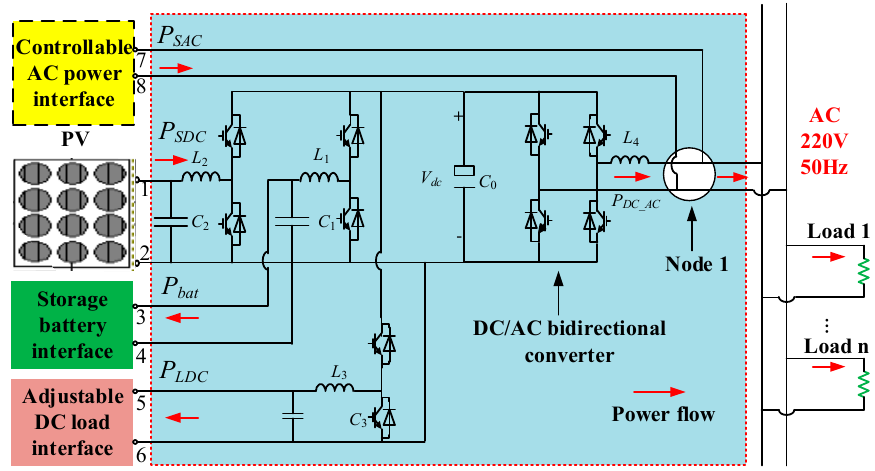
Figure 13. Power flow of SPEER in isolated network Figure 2.